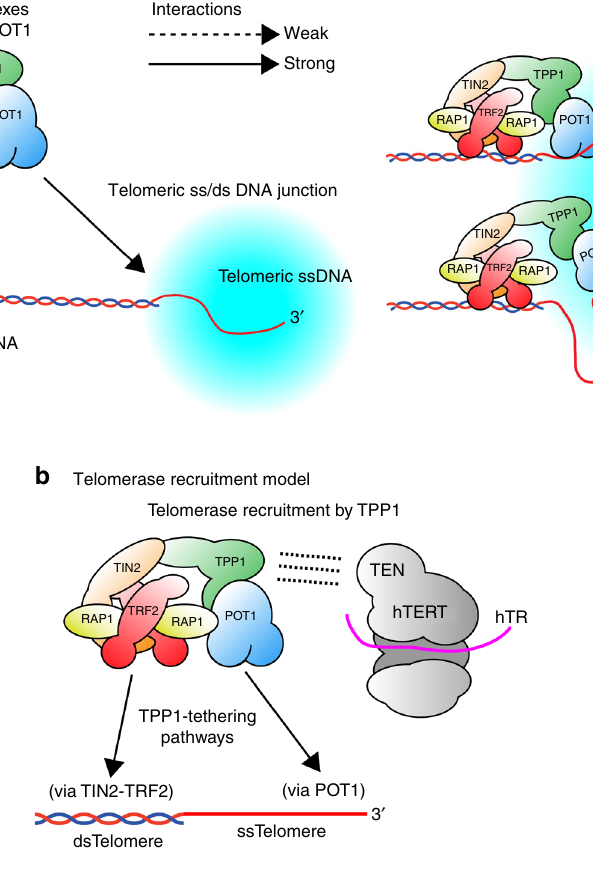
Fig. 8 Models for shelterin search mechanism for telomeric 3 ′ end and telomerase recruitment based on the shelterin core complex. a A model for shelterin positioning at the telomeric 3 ′ end suggests a shelterin complex such as shelterin (core) would fi rst localize to a ss/ds telomeric DNA junction via TRF2 and POT1 binding (shown here via internal ss-telomeric region). Then the POT1 component would seek the higher af fi nity 3 ′ TTAG end, thus protecting the chromosome end. b Dual pathways exist for TPP1 tethering to telomeres, either via TIN2 – TRF2 or via POT1, both of which would facilitate